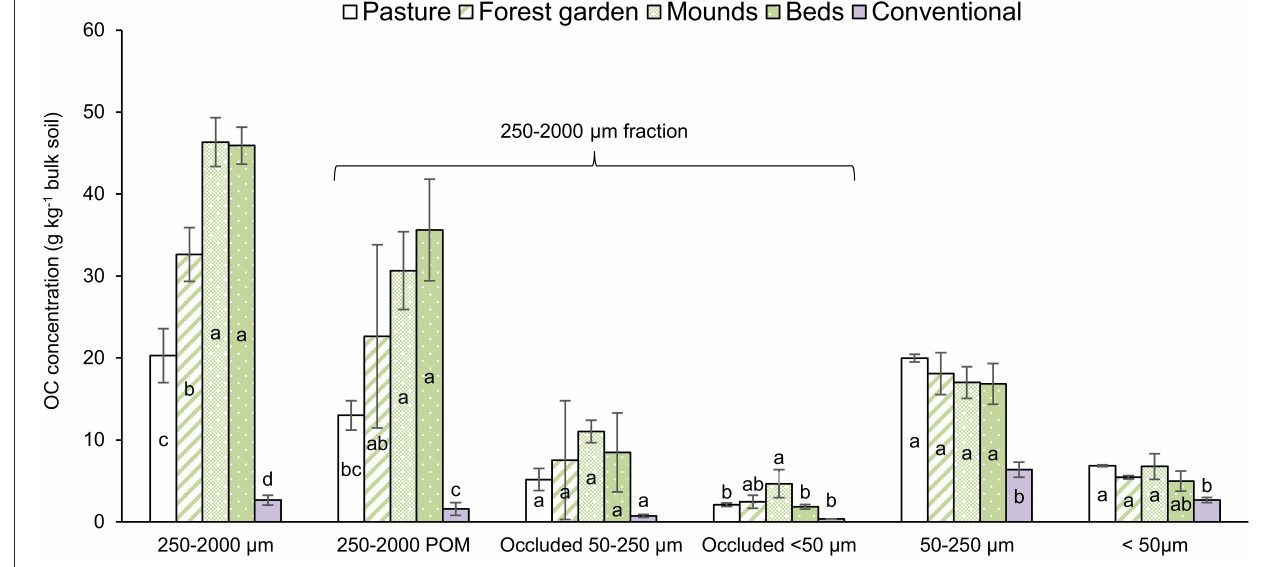
FIGURE 4 | OC distributions in the soil aggregate-size fractions (in grams OC per kilo bulk soil). Various letters represent significant differences at the 95% confidence level (LSD Tukey; n = 3). Bars indicate standard deviation of the